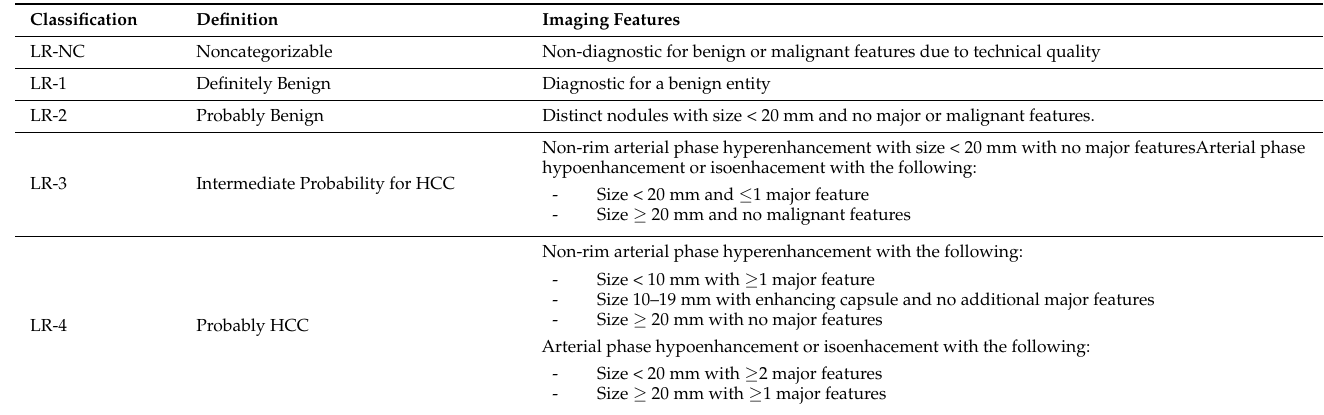
Figure 1. MRI of a patient with chronic HBV. Table 1. Liver Imaging Reporting and Data System (LI-RADS). Table 1. Liver Imaging Reporting and Data System